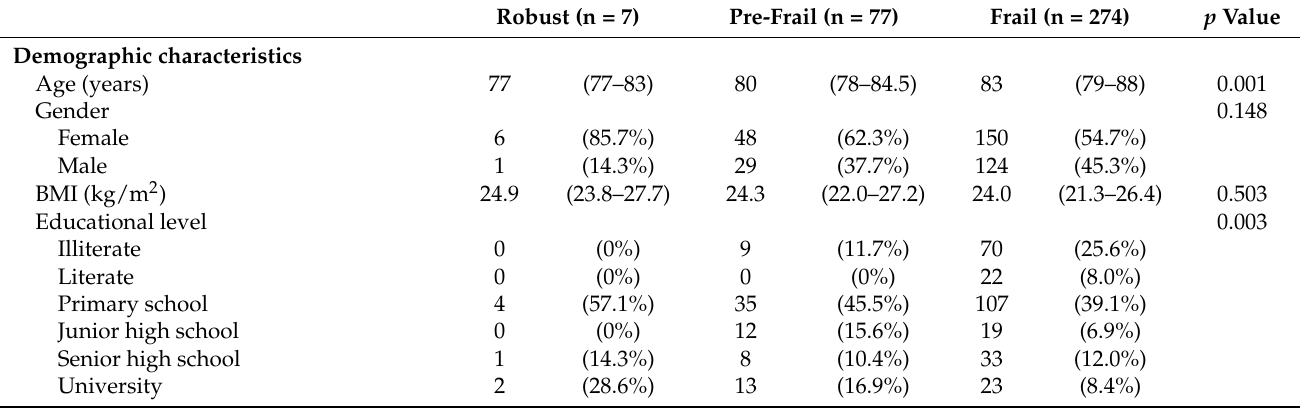
Table 2. Comparison between frailty, pre-frailty, and